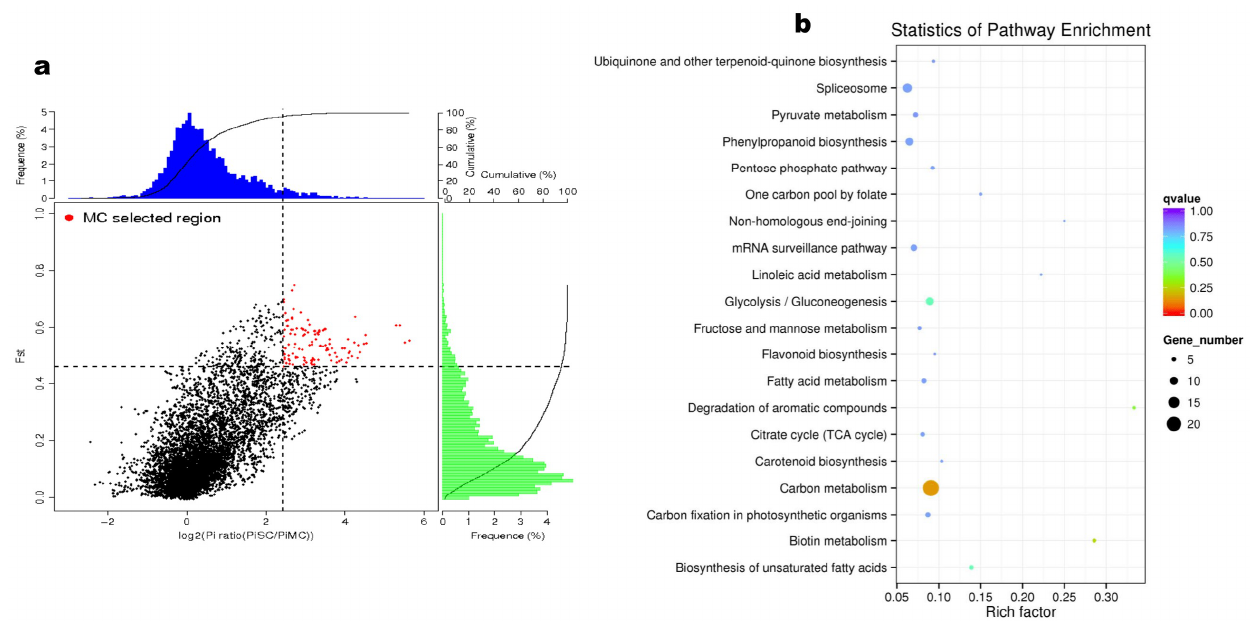
Figure 2. Genetic diversity and gene flow among the subpopulations. ( a ) The diversity ( π ) and genetic distance ( F ST ) across the groups, where green, light blue, and blue colors indicate SC, NC, and MC, respectively; the radius of pie: genetic diversity; and dashed line length: F ST value between two groups. SC, NC, and MC represent the subpopulations from the genetic diversity analysis. ( b ) Linkage disequilibrium (LD) differences between subpopulations. ( c ) Distribution of Tajima’s D values. The white line indicates the mean. ( d ) Most frequently found maximum-likelihood trees for gene flow among the subpopulations by Treemix. ( e ) The residual fit values obtained from the maximum likelihood tree ( d ). The plot was constructed using the normalized residual covariances by dividing the residual covariance value between each pair of populations by the standard deviation between all sample pairs. On the right is the color ruler.